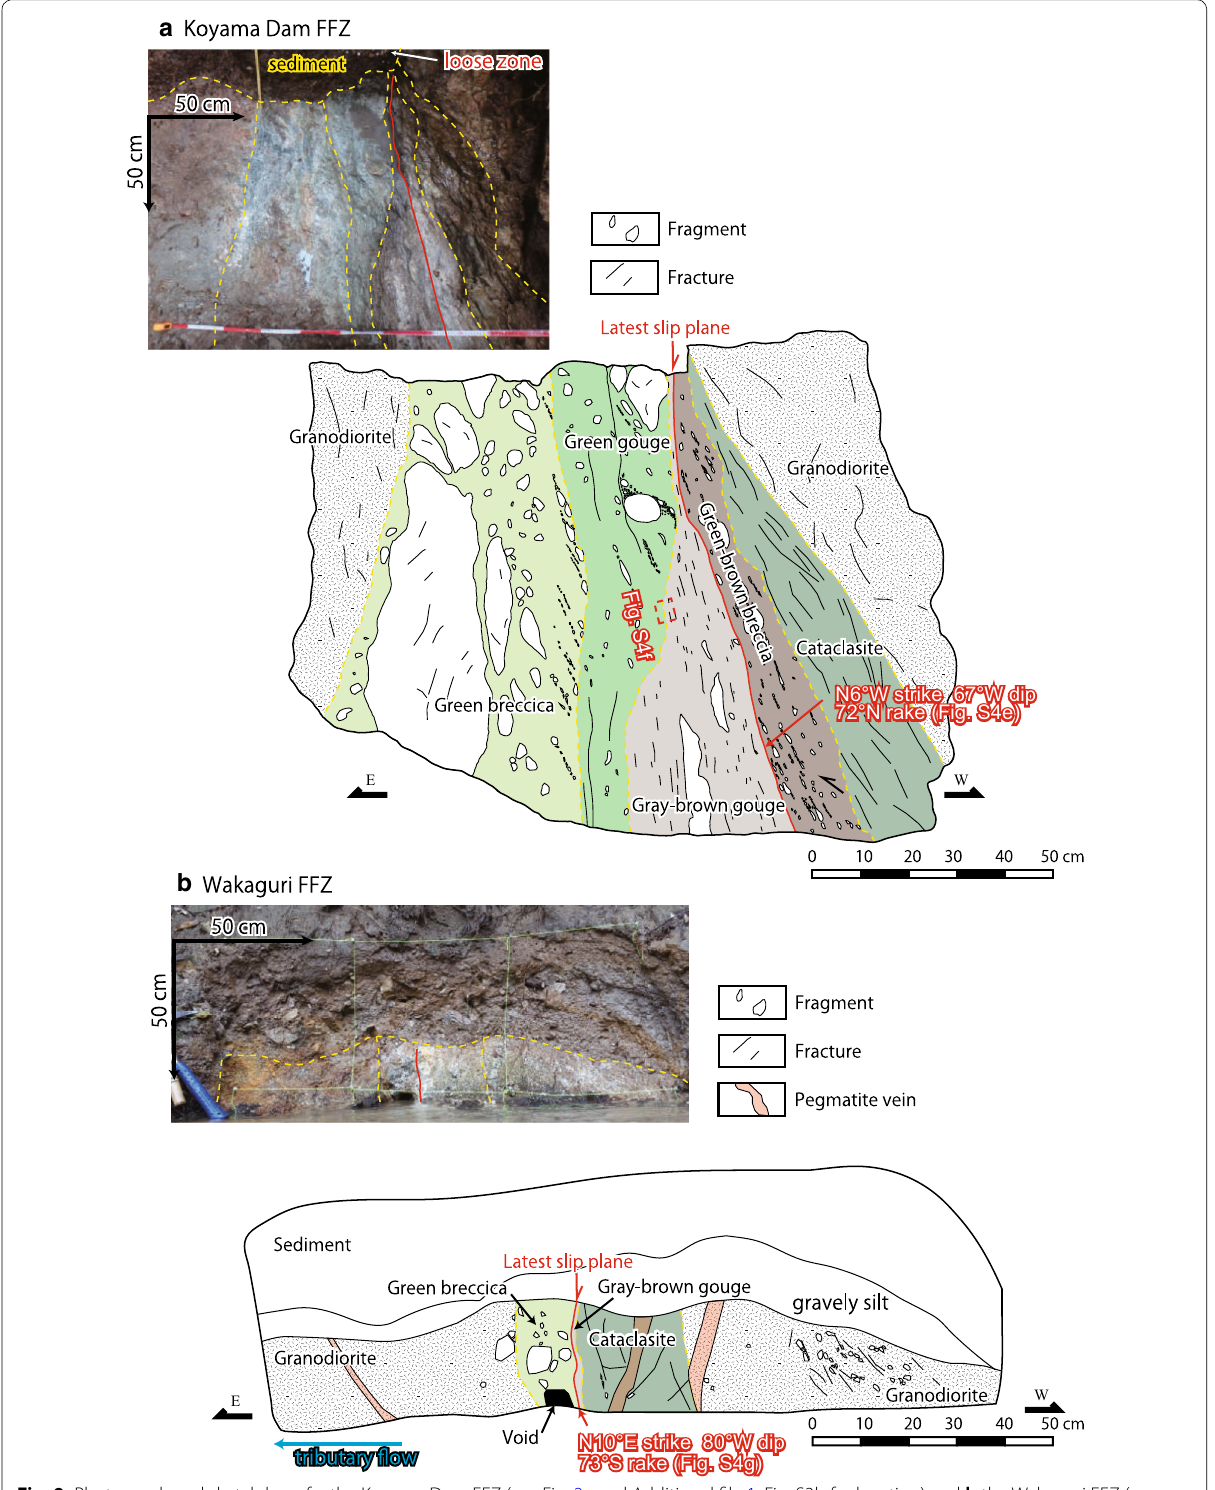
Fig. 9 Photograph and sketch log of a the Koyama Dam FFZ (see Fig. 2c and Additional file 1: Fig. S3b for location) and b the Wakaguri FFZ (see Fig. 2c and Additional file 1: Fig. S3e for location). Yellow-dashed lines indicate boundaries of lithofacies in